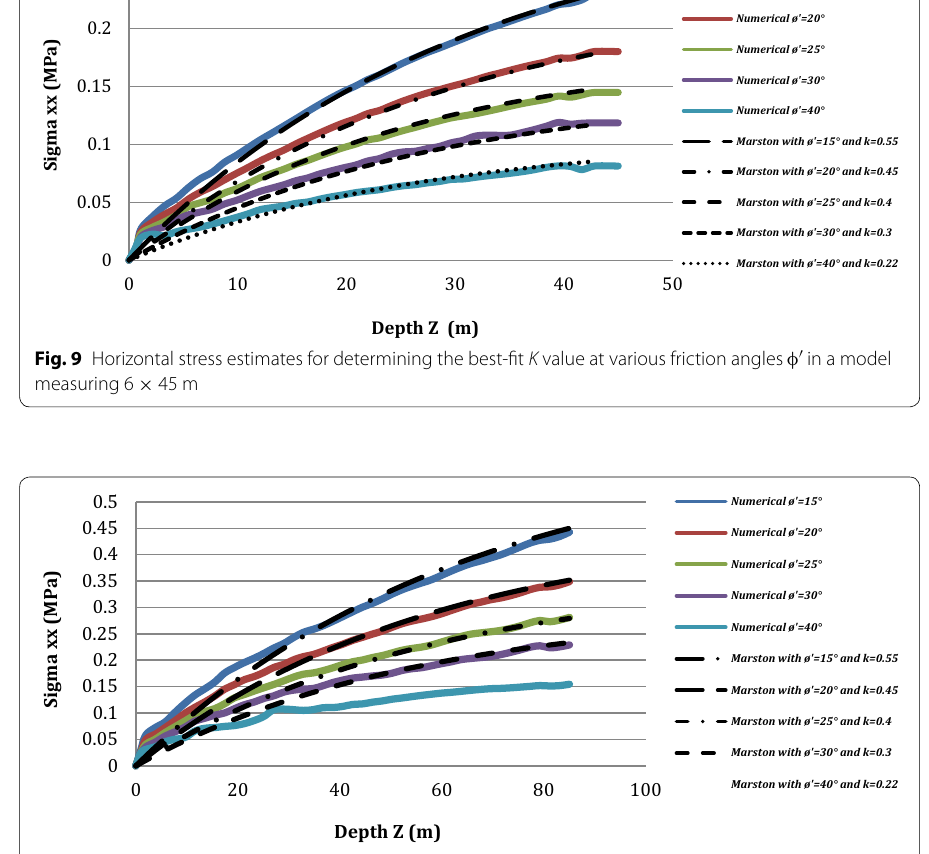
Fig. 10 Horizontal stress estimates for determining the best-fit K value at various friction angles φ ′ in a model measuring 12 90 ×